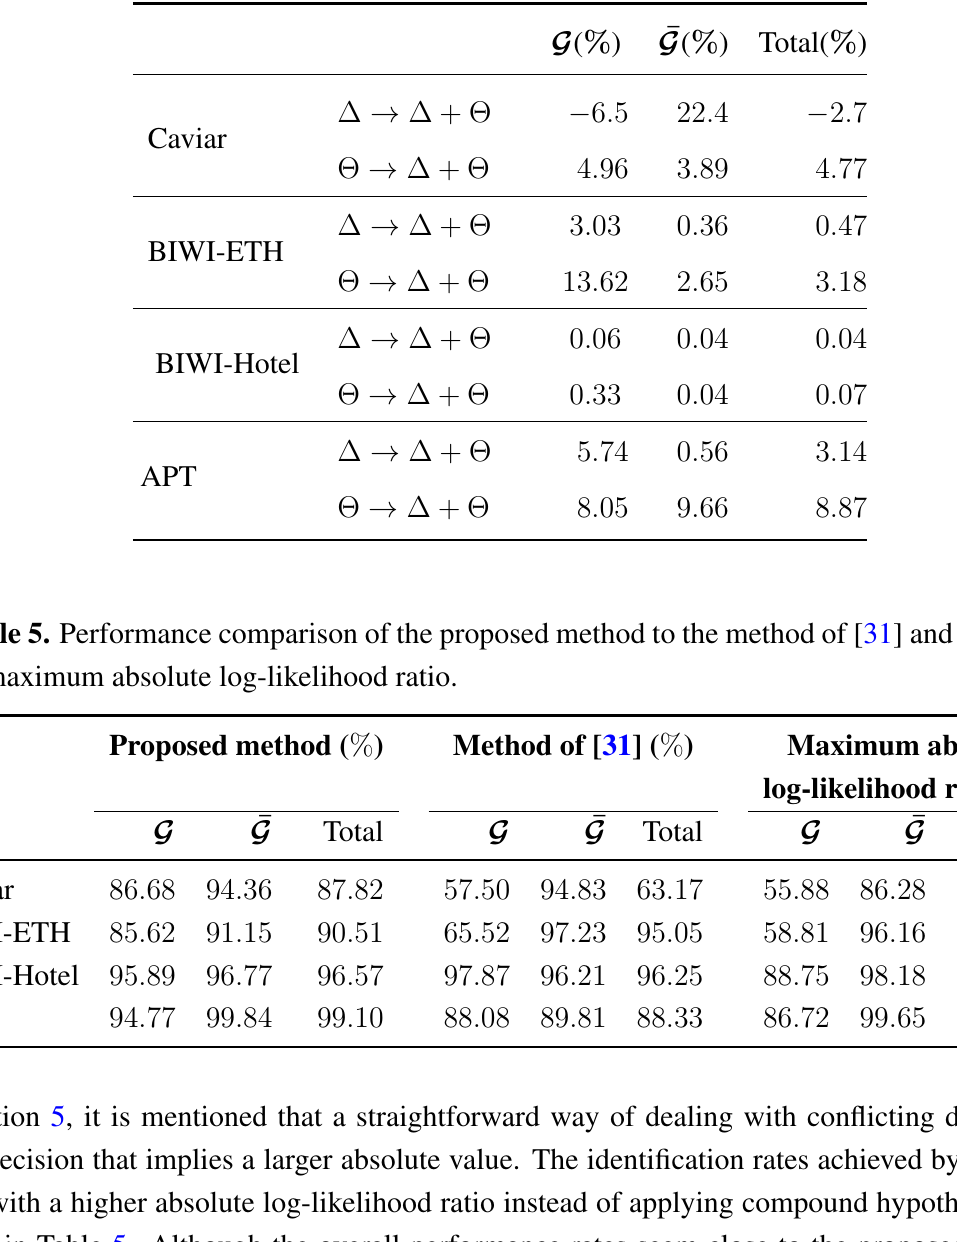
Table 4. Improvement introduced by compound evaluation over individual decisions.